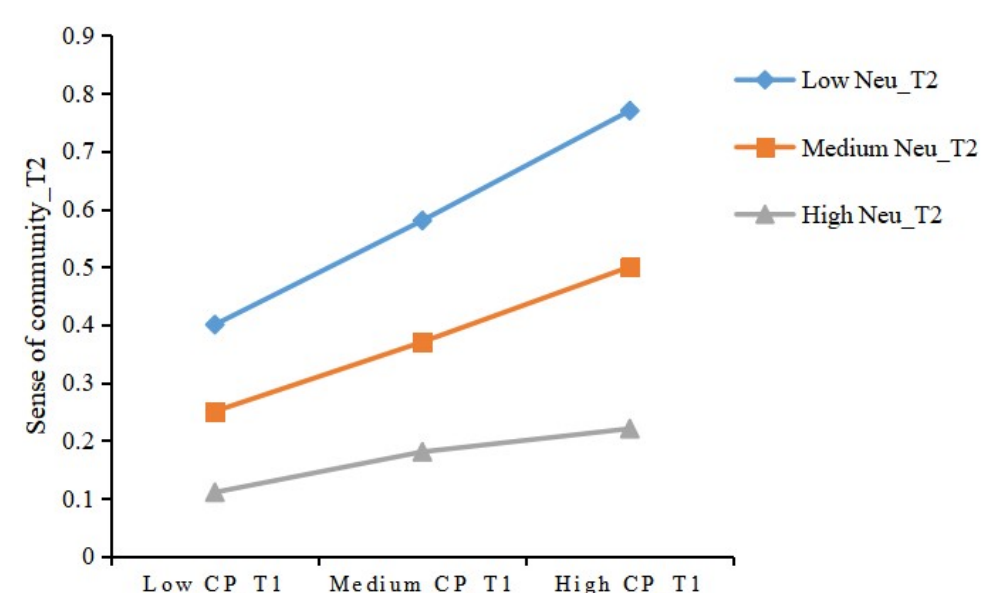
Figure 1. Community participation and sense of community: Moderating role of neuroticism. Note. CP and Neu represent community participation and neuroticism.